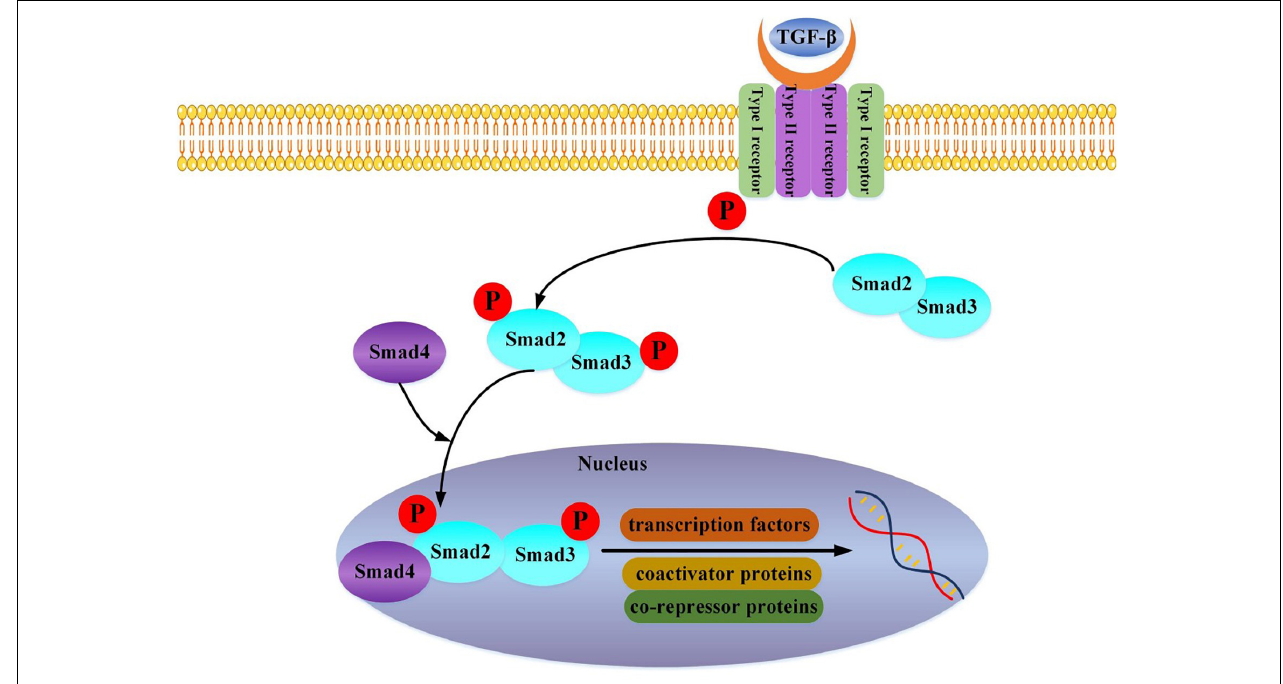
FIGURE 1 | TGF-beta binds to the Type II receptor and recruits the Type I receptor, whereby the Type II receptor phosphorylates and activates Type I. The Type I receptor, in turn, phosphorylates receptor-activated Smad2 and Smad3. Then Smad2, Smad3, and Smad4 combine and translocate into the nucleus together. The interaction of the Smad complex with other DNA binding proteins (transcription factors, coactivator proteins, co-repressor proteins) activates specific gene